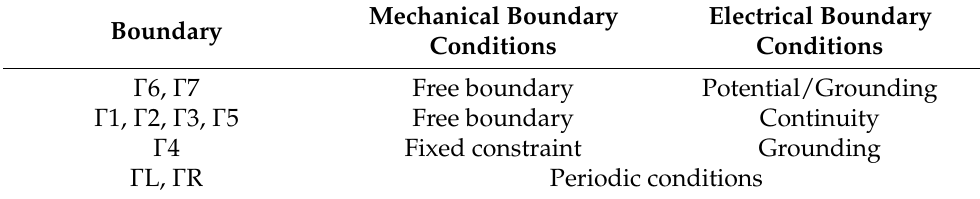
Table 3. Boundary conditions of the model.